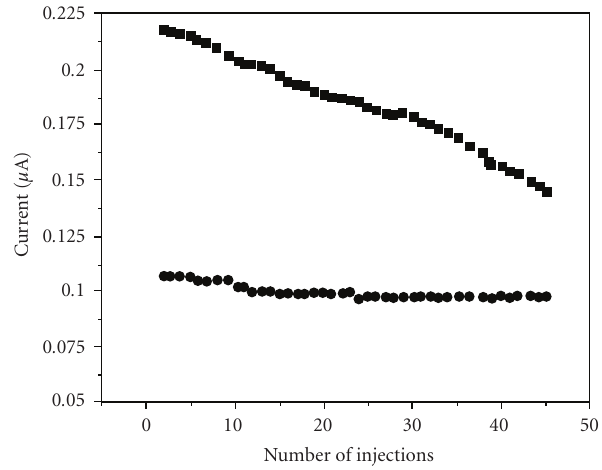
Figure 4: E ff ect of EDTA solution on the operational stability of the gold screen-printed electrode. High level (100.0 mg · L − 1 , square) or low level (50.0 mg · L − 1 , circle) refers to successive injection of standard-solutions of gallic in phosphate bu ff er. R (cid:3) is the flow rate which depending on the experiments; it is distilled water for 100.0 mg · L − 1 gallic acid and 0.25 M EDTA solution for 50.0 mg · L − 1 gallic